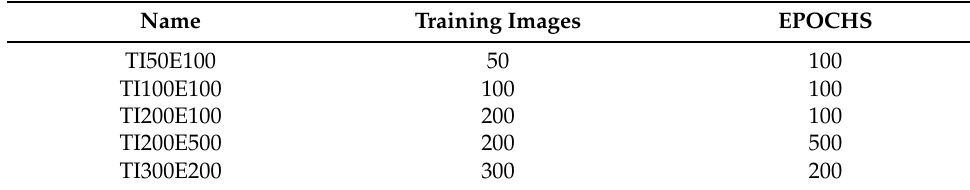
Table 4. Summary of trained networks.